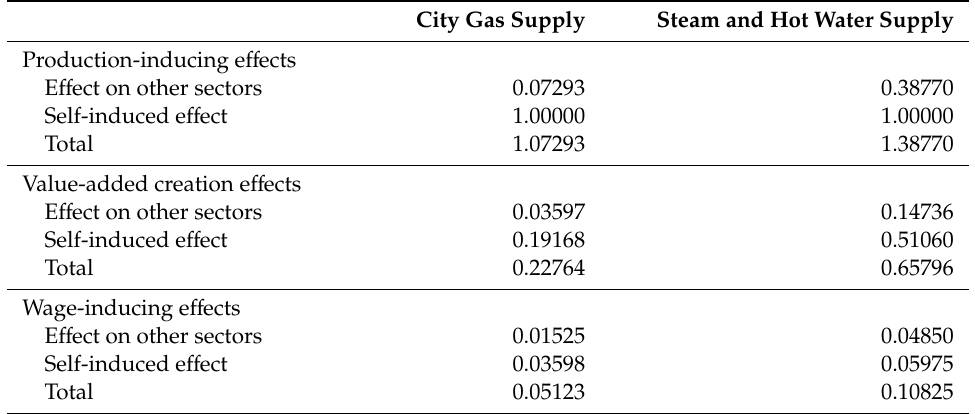
Table 5. Summary of the economic e ff ects of steam and hot water supply and city gas supply